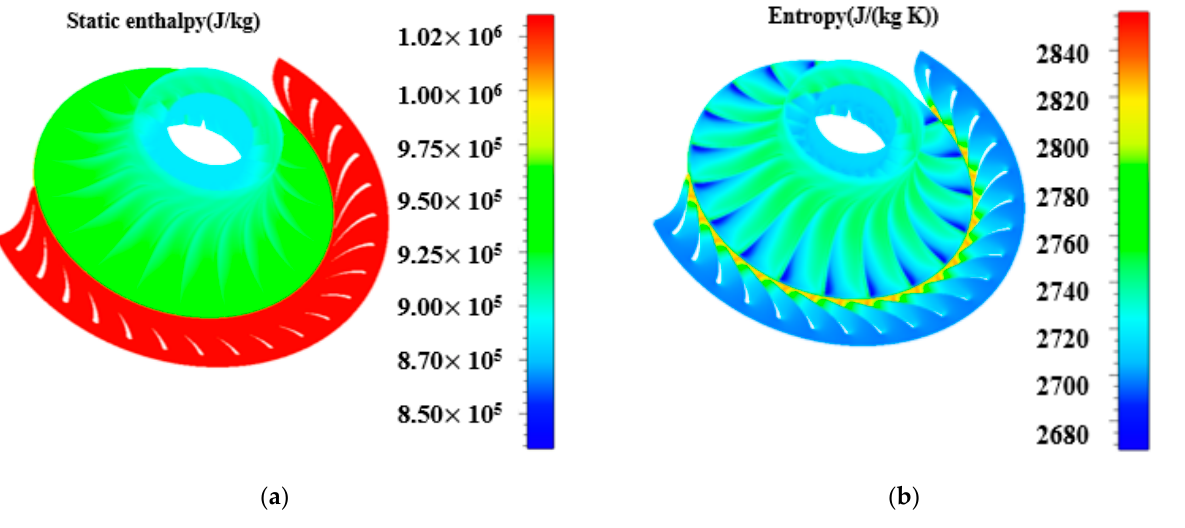
Figure 8. Contours of enthalpy and entropy at 50% blade span. ( a ) Static enthalpy; ( b ) entropy.